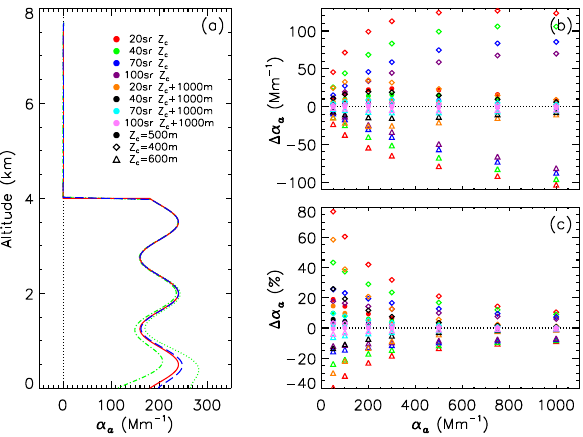
Fig.5. Lidarsignalsimulationwiththepurposeofshowingtheeffectofthelidarratio S usedintheretrieval. (a) Fig.4. Lidarsignalsimulationwithanoscillatingaerosolprofile. (a) Redsolidline: exampleoriginalprofile Fig. 5. Lidar signal simulation with the purpose of showing the ef- Fig. 4. Lidar signal simulation with an oscillating aerosol pro- Originallidarratio S 0 =70 sr; (b) originallidarratio S 0 =40 sr. Redsolidline,originalprofile;bluedashed centeredabout200Mm − 1 ,with S 0 =70 sr;dashedblueline: retrievedprofilewith Z c =500 m(attheoscil- fect of the lidar ratio S used in the retrieval. (a) Original lidar ratio line,retrievedprofilewith S = S 0 ;greendottedline,retrievedprofilewith S = S 0 − 30 sr;greendash-dotline, file. (a) Red solid line: example original profile centred about lation maximum) and S = S 0 ; dotted green line: retrieved profile with Z c =400 m; dash-dotted green line: retrievedprofilewith S = S 0 +30 sr. S 0 = 70sr; (b) original lidar ratio S 0 = 40sr. Red solid line, orig- retrieved profile with Z c =600 m. (b, c) Difference ∆ α a , between the retrieved and the original profile at 200Mm − 1 , with S 0 = 70sr; dashed blue line: retrieved profile with givenfixedaltitudes,inabsoluteandrelativeterms,respectively. Differentsymbolsindicatedifferentreference inal profile; blue dashed line, retrieved profile with S = S 0 ; green Z c = 500m (at the oscillation maximum) and S = S 0 ; dotted green heights: solidcircles,500m;diamonds,400m;triangles,600m. Differentcoloursindicatedifferentcombina- dotted line, retrieved profile with S = S 0 − 30sr; green dash-dot line: retrieved profile with Z c = 400m; dash-dotted green line: re- tionsofthelidarratioandthealtitudewhere ∆ α a isevaluated: red,20sr, Z c ;green,40sr, Z c ;blue,70sr, Z c ; darkpurple,100sr, Z c ;orange,20sr, Z c +1 km;black,40sr, Z c +1 km;cyan,70sr, Z c +1 km;lightpurple, line, retrieved profile with S = S 0 + trieved profile with Z c = 600m. (b, c) Difference 1α a , between 100sr, Z c +1 km. the retrieved and the original profile at given fixed altitudes, in ab- solute and relative terms, respectively. Different symbols indicate different reference heights: solid circles, 500m; diamonds, 400m; 20 triangles, 600m. Different colours indicate different combinations of the lidar ratio and the altitude where 1α a is evaluated: red, 20sr, 19 Z c ; green, 40sr, Z c ; blue, 70sr, Z c ; dark purple, 100sr, Z c ; orange, 20sr, Z c + 1km; black, 40sr, Z c + 1km; cyan, 70sr, Z c + 1km; light purple, 100sr, Z c + 1km.